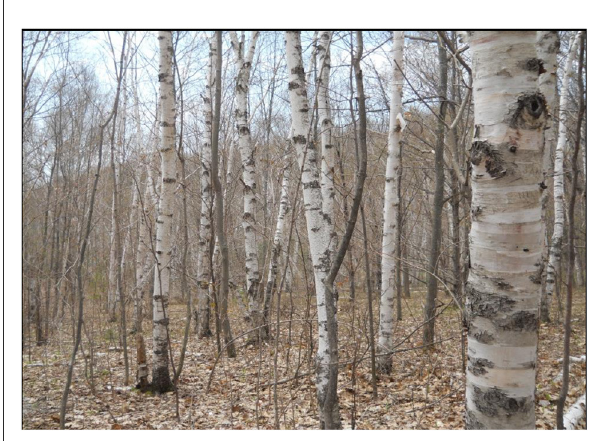
FIGURE9 Coastal dune at SLBE.